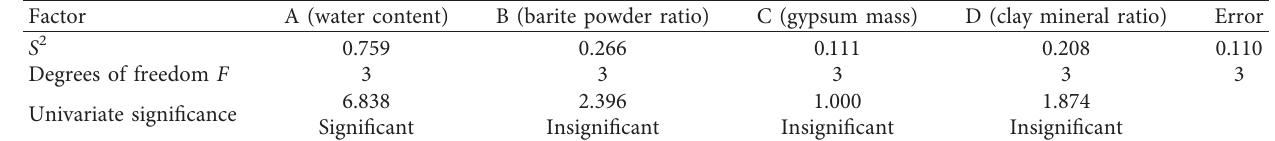
Figure 8: Range analysis of the factors affecting elastic modulus. Table 15: Variance analysis of elastic modulus.